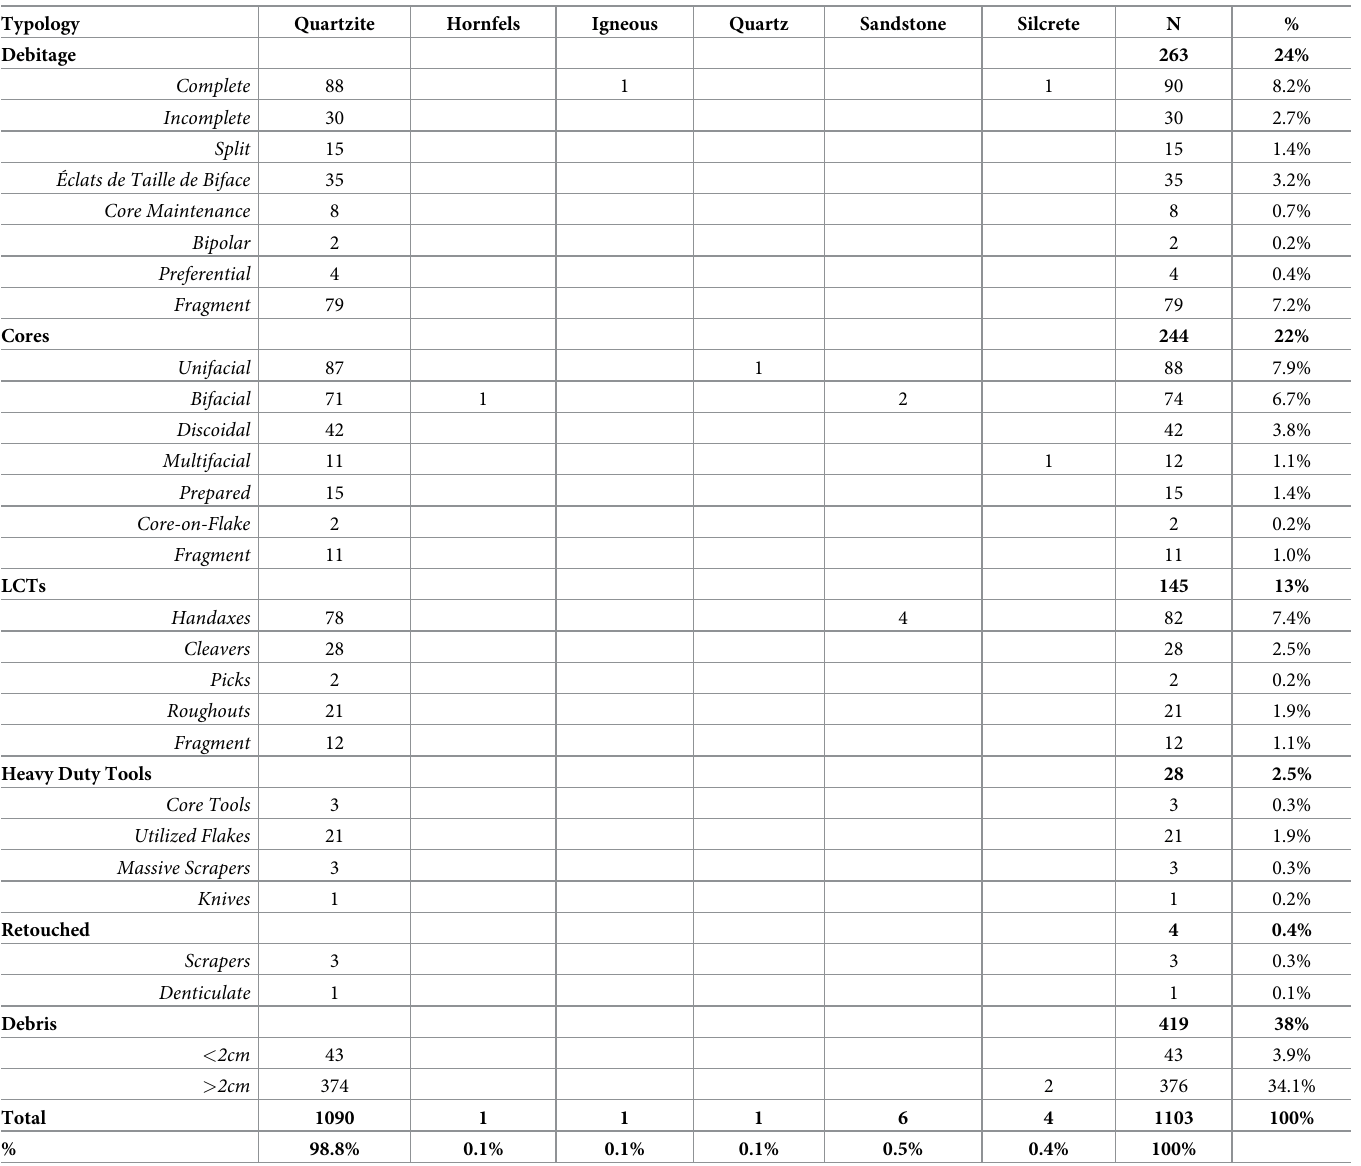
Table 2. Typology and Raw material of stone